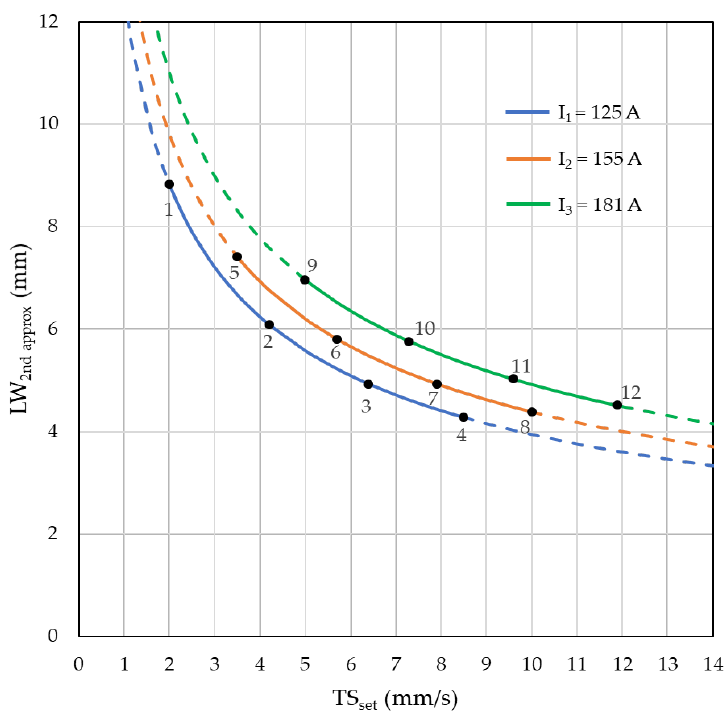
Figure 12. Superimposition of the initial experimental design (4 travel speeds for each of the 3 currents = 12 experiments) over the second approximation operational map.